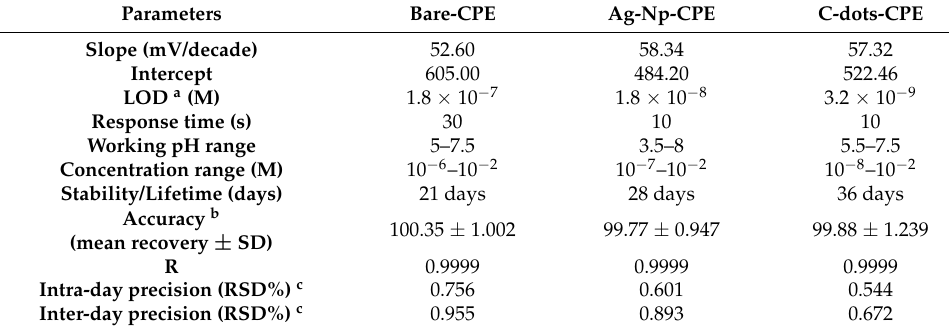
Table 1. Performance characteristics of the three fabricated electrodes.